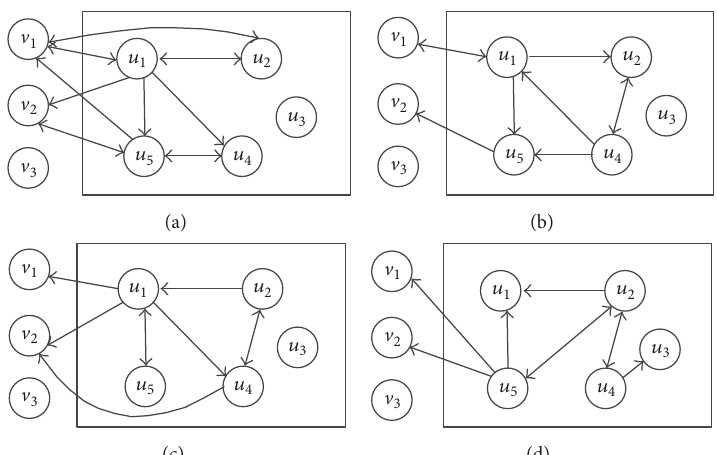
Figure 3: An example of calculating MW: there are five users inside a community, that is, 𝑢 1 , 𝑢 2 , 𝑢 3 , 𝑢 4 , and 𝑢 5 . There are three users outside the community, that is, V 1 , V 2 , and V 3 . (a) shows the relationship between these users. (b) shows the diffusion of theme information from 𝑢 1 . (c) also shows the diffusion of theme information from 𝑢 1 . (d) shows the diffusion of theme information from 𝑢 2 . 𝑔 V diffuses the 𝑢𝑗 . The parameter Diffu V ,𝑡 𝑢𝑗 indicates whether theme information that he/she